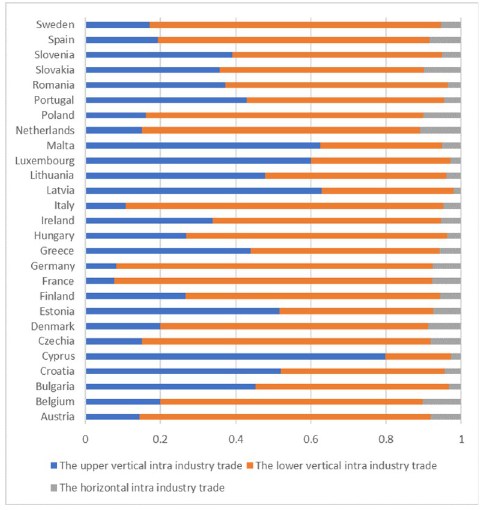
Fig 2. Proportion of intra industry trade structure of China’s equipment manufacturing industry to the EU countries in 2020.